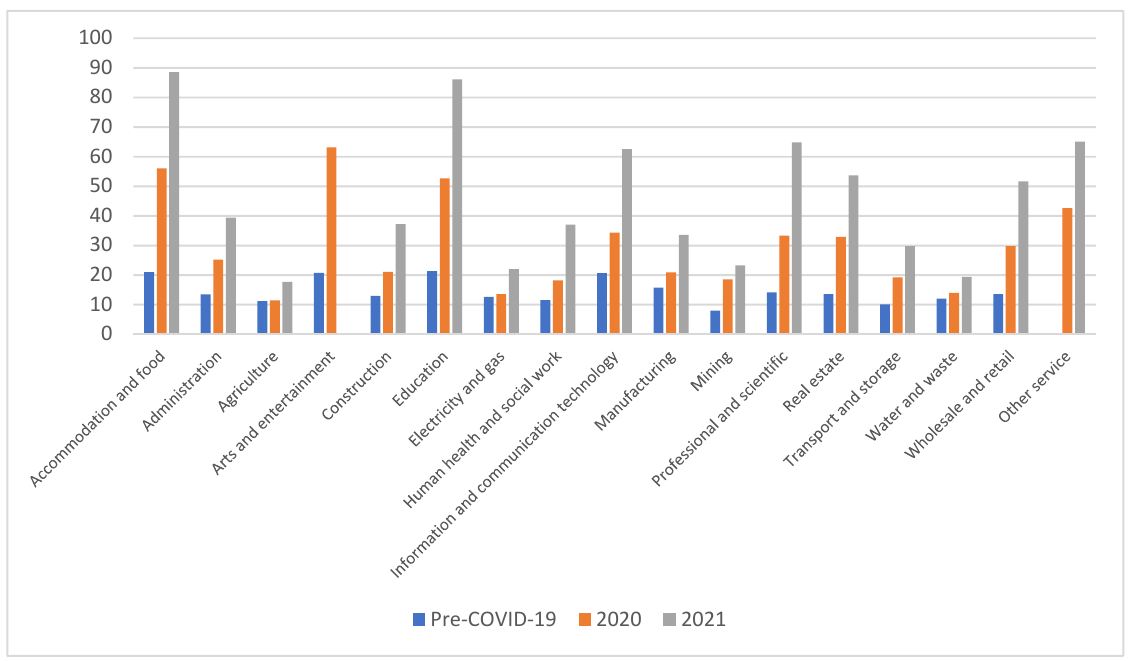
Figure 3. Share of company debt with interest coverage ratio less than one worldwide from 2019 to 2021, by sector. Source: IMF, Orbis Research 2022.